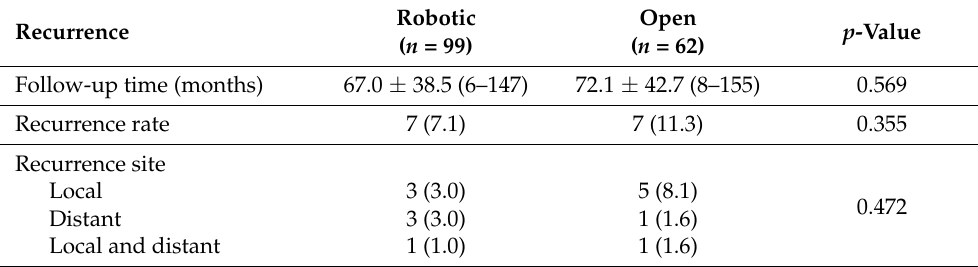
Table 6. Comparison of follow-up time and recurrence rate and site between patients treated with robotic and open thyroidectomy.